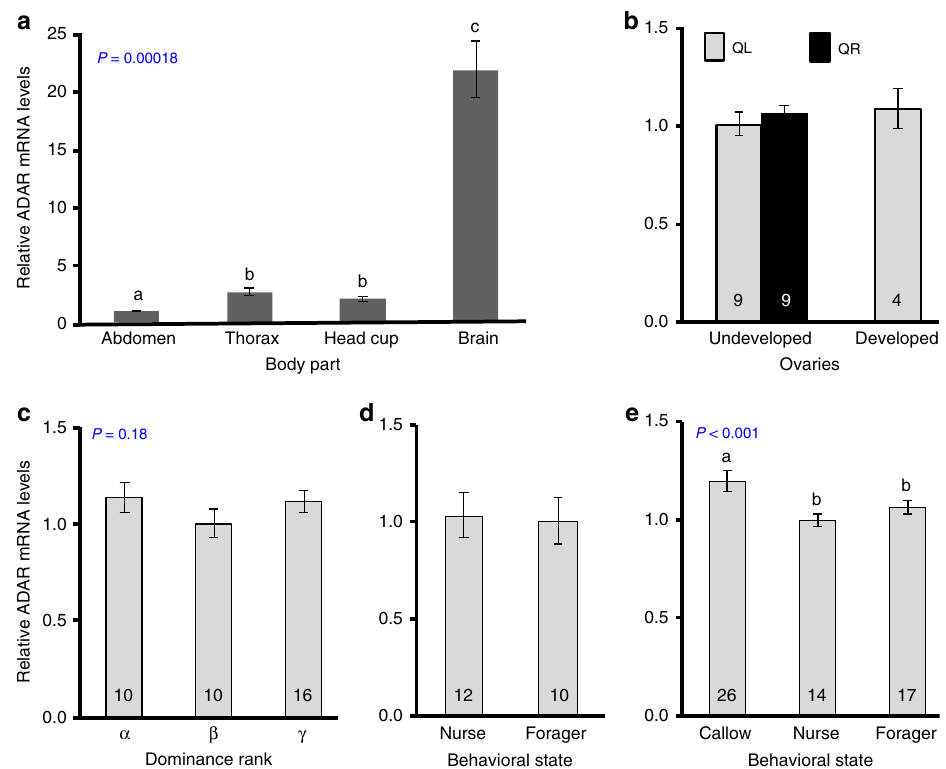
Fig. 6 ADAR transcript abundance. a BtADAR mRNA levels are enriched in the brain, compared with the rest of the body. The P -value was obtained from a Kruskal – Wallis analysis; body parts marked with different letters differ in a Mann – Whitney test with Bonferroni correction for multiple comparisons. Sample size was six bees. b Ovarian state and queen presence do not in fl uence brain BtADAR mRNA abundance (Two-way ANOVA; ovarian development, P = 0.42; queen presence, P = 0.41); QR = queenright colonies, QL = queenless (orphan) groups of bees). c Dominance rank in groups of three queenless workers did not affect brain BtADAR mRNA levels (One-way ANOVA test, P = 0.18). d , e Nurses and foragers have similar brain ADAR transcript levels in free-foraging queenright colonies of B. terrestris ( d , Mann – Whitney test P = 0.39) and honeybees ( e , one-way ANOVA test, bars with different small